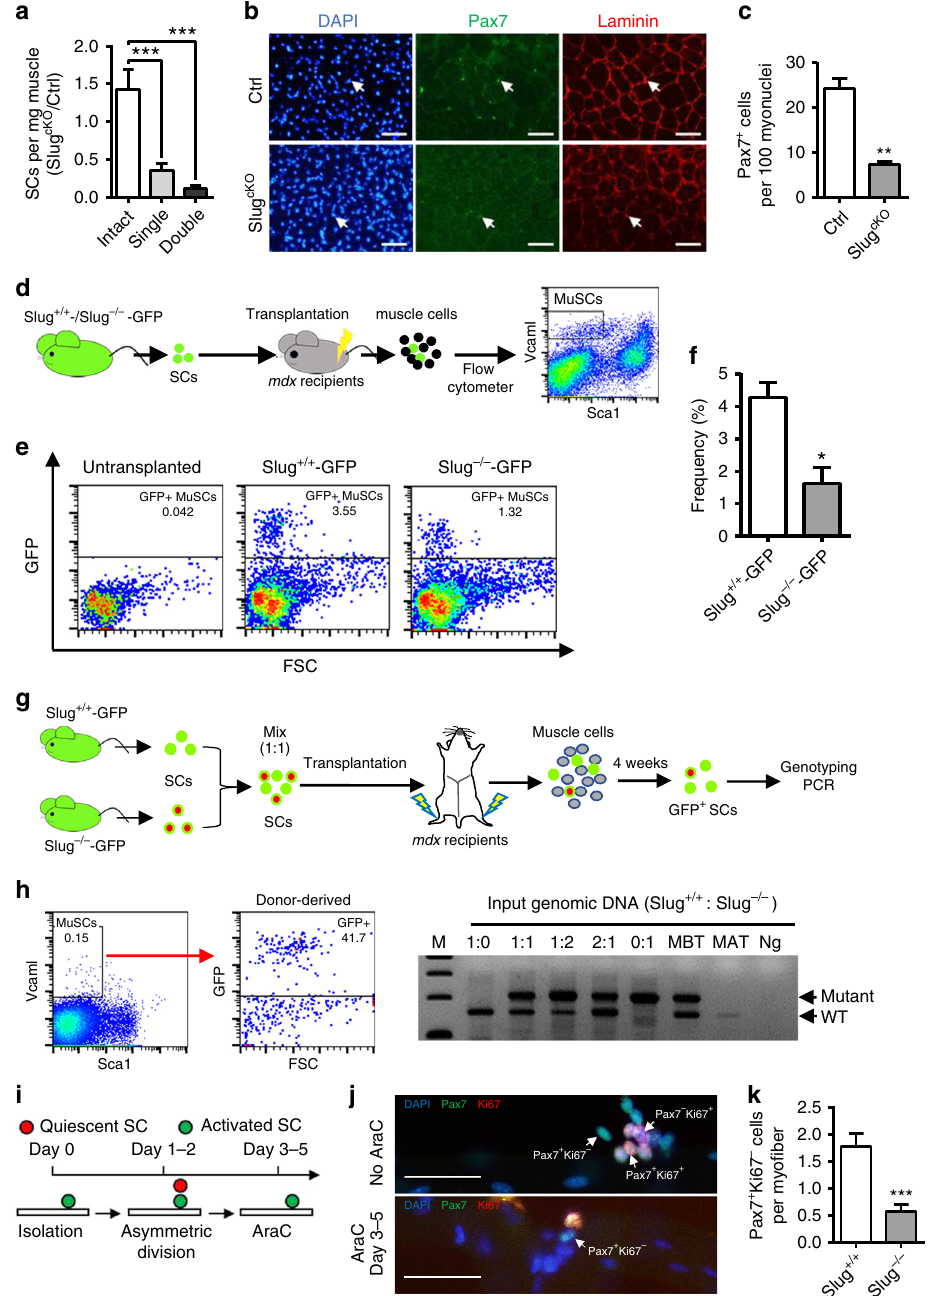
Gene ontology enrichment analysis of biological processes (GOBP) identi fi ed that Slug silencing derepressed sets of genes related to transcription regulation, cell proliferation, and skeletal muscle differentiation processes (Fig. 4a, left panel). Notably, the genes downregulated upon Slug silencing identi fi ed enrichment of genes among various categories of cellular defense responses (Fig. 4a, right panel). Interestingly, p16 Ink4a was listed in the most upregulated genes ranked in negative regulation of cell pro- liferation. It was previously reported that self-renewal capacity of aged stem cells (hematopoietic stem cells 23 , intestinal stem cells 24 , and skeletal MuSCs 5 ) was attenuated. Therefore, we postulated p16 Ink4a as a potential mediator for SC self-renewing defect caused by Slug de fi